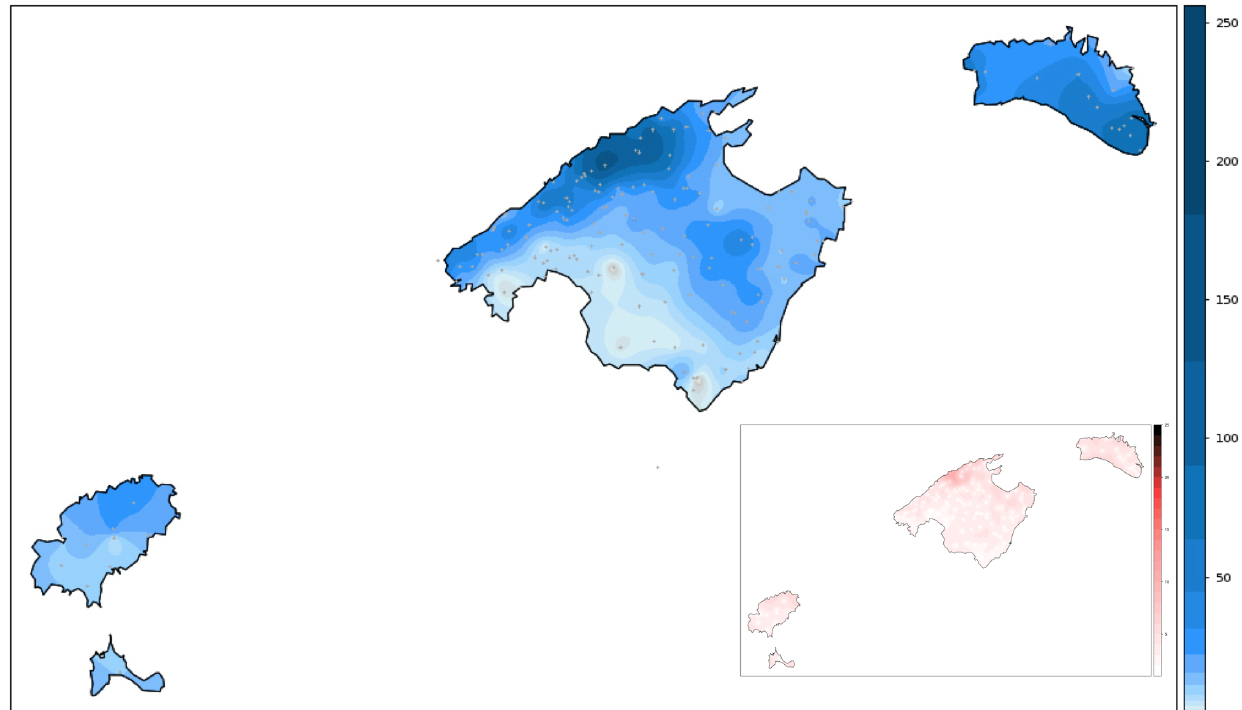
Figure 5. As in Fig. 4, but for 11 November